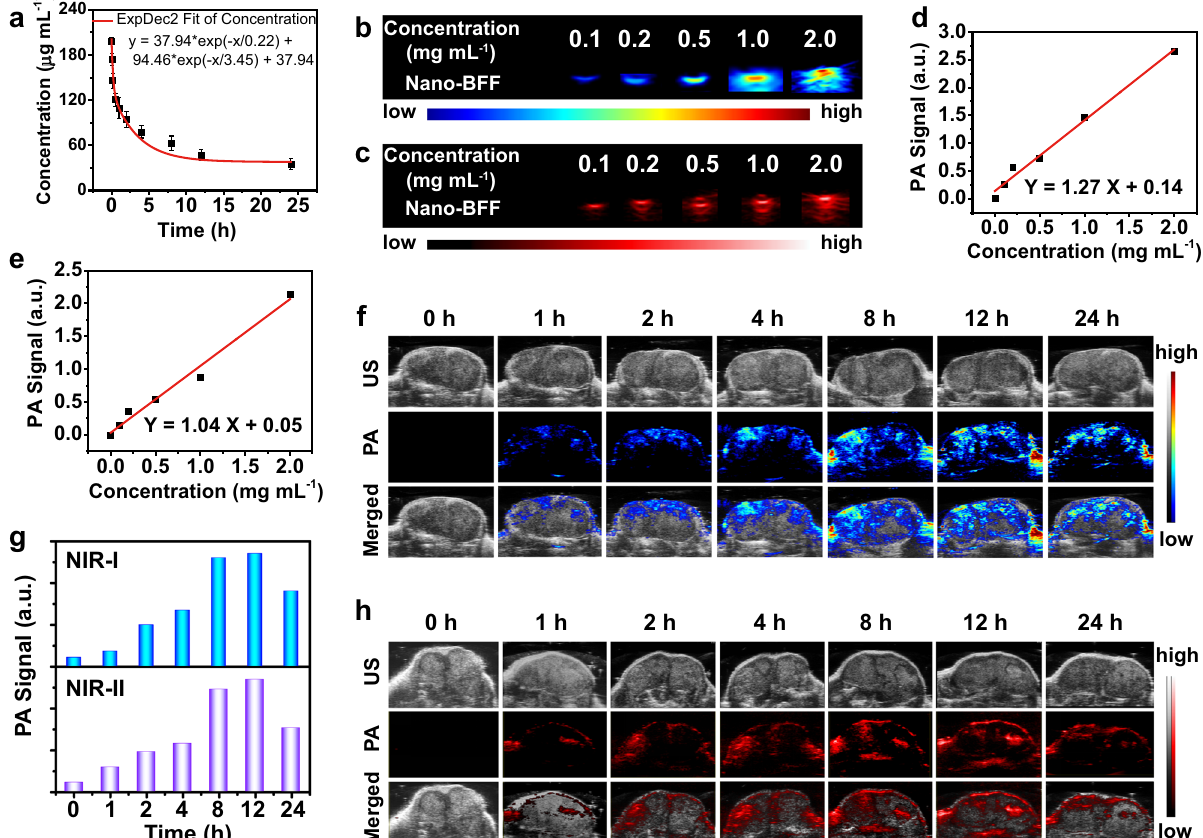
Fig. 4 In vivo pharmacokinetic analysis and PA imaging of Nano-BFF. a Blood circulation pro fi le of Nano-BFF after intravenous administration ( n = 3 biologically independent samples). Data are presented as mean values ± SD. b , c PA images of Nano-BFF under excitation at b 900 nm and c 1200 nm at varied concentrations. d , e Plot of PA amplitudes using Nano-BFF at d 900 nm and e 1200 nm as a function of the dose of Nano-BFF. f – h In vivo PA images of tumors in the f NIR-I and h NIR-II biowindow, as well as g corresponding PA values after intravenous injection of Nano-BFF (20 mg kg − 1 ) at various time